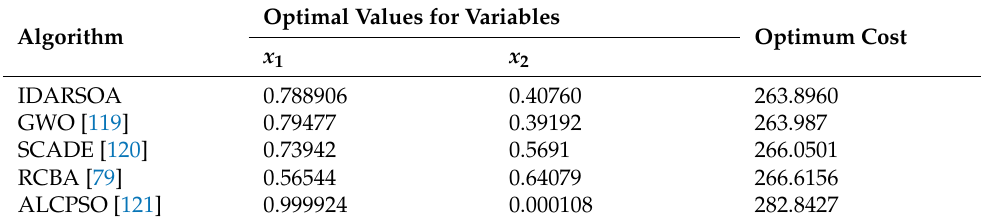
Table 16. Comparison results of the three-bar truss design